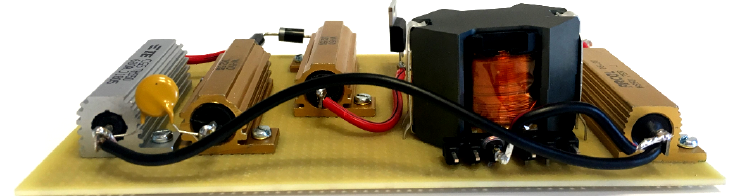
Figure 5. A physical prototype electronic emulator of biological tissue as an electrical load during